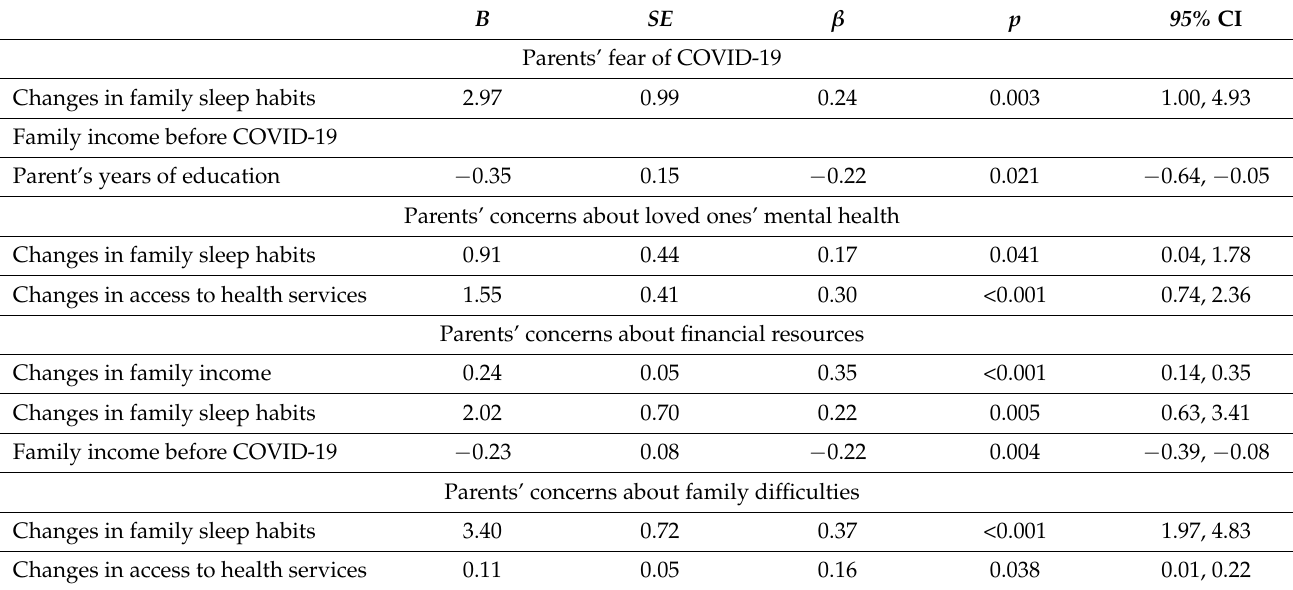
Table 2. Multiple regressions testing associations between parents’ COVID-19 fear/concerns and lockdown related changes and health